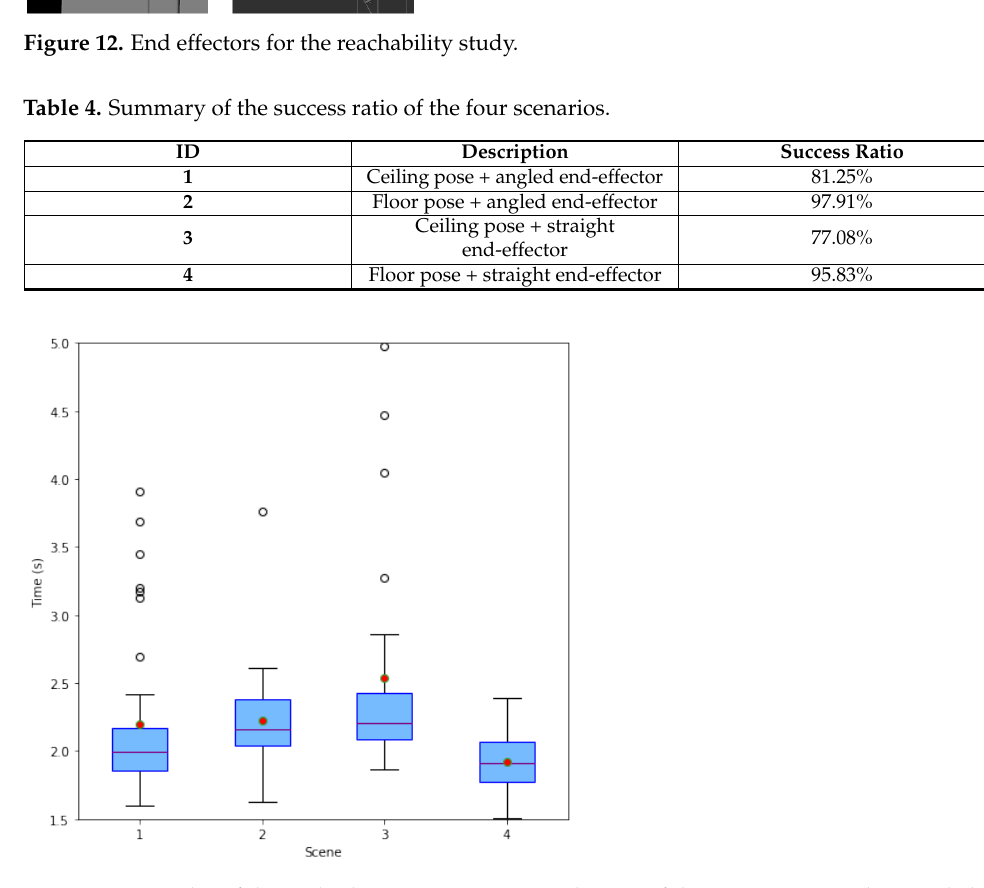
Figure 13. Box plot of the path planning computational times of the success rates. The purple line represents the median of the distribution, and the red dot the